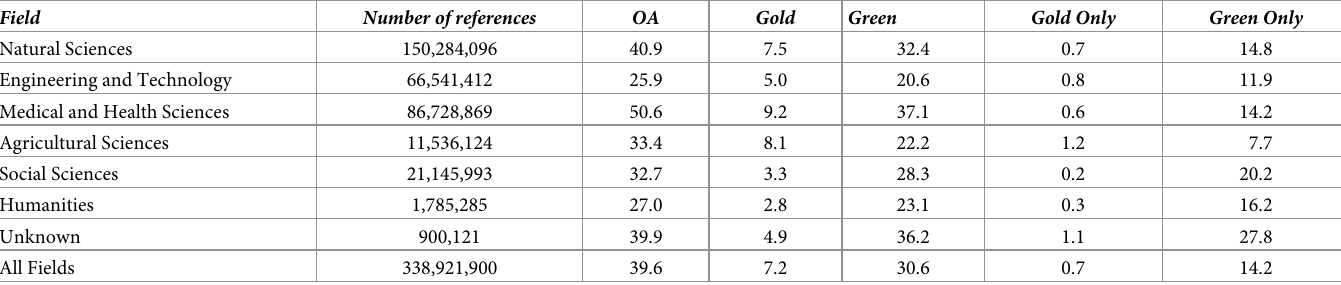
Table 2. Proportion references to OA by type and by fields.